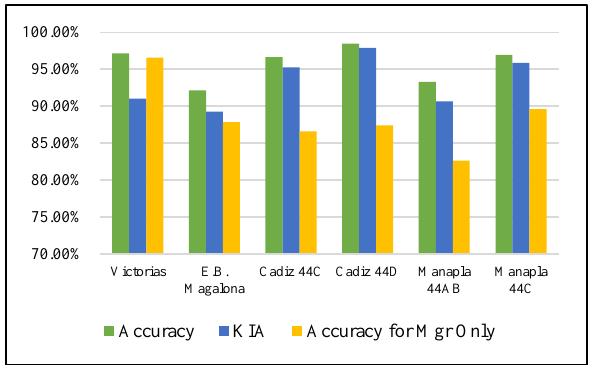
Figure 7. Shows graph of mangrove overall accuracy